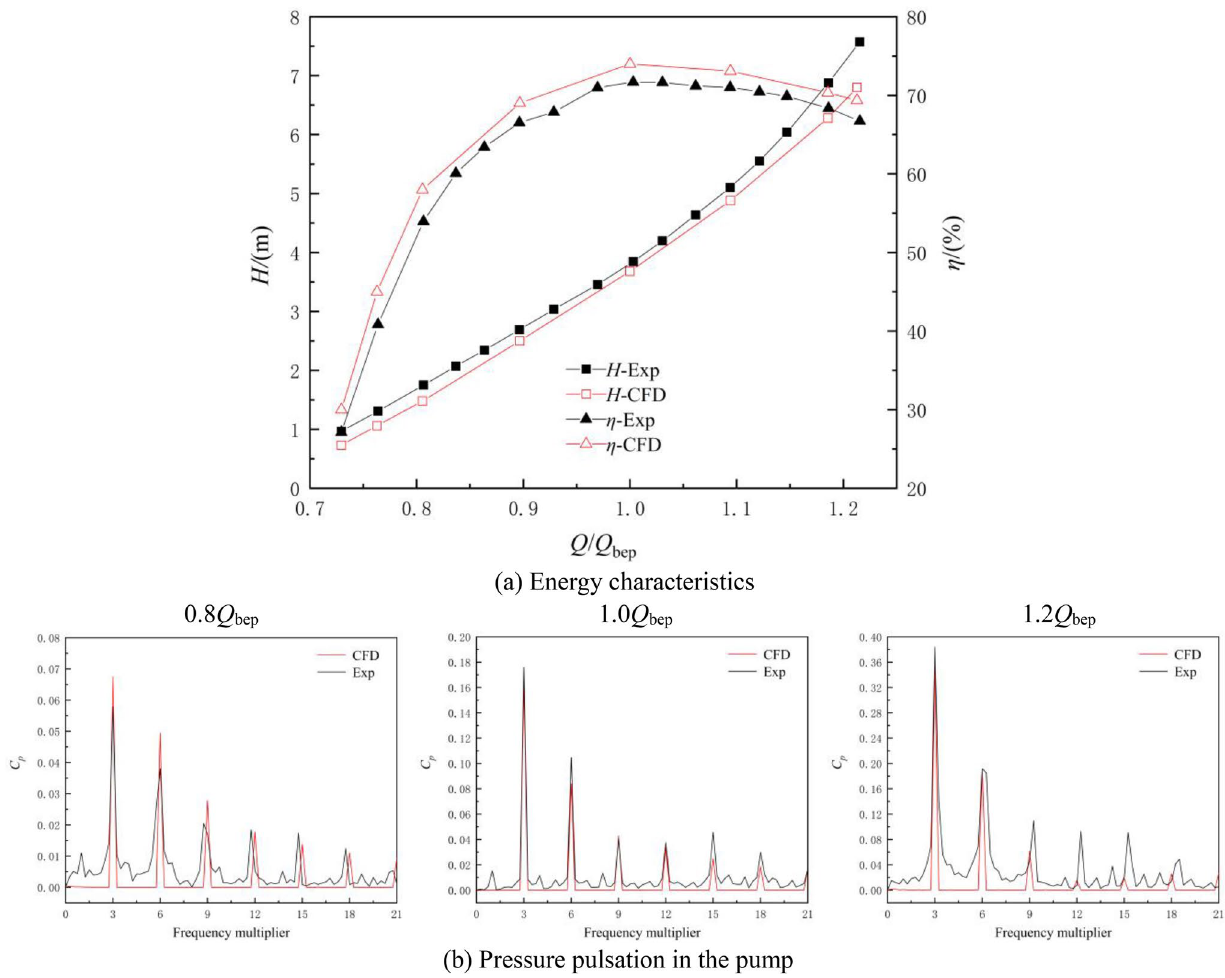
Figure 5. Comparison between numerical results and experimental